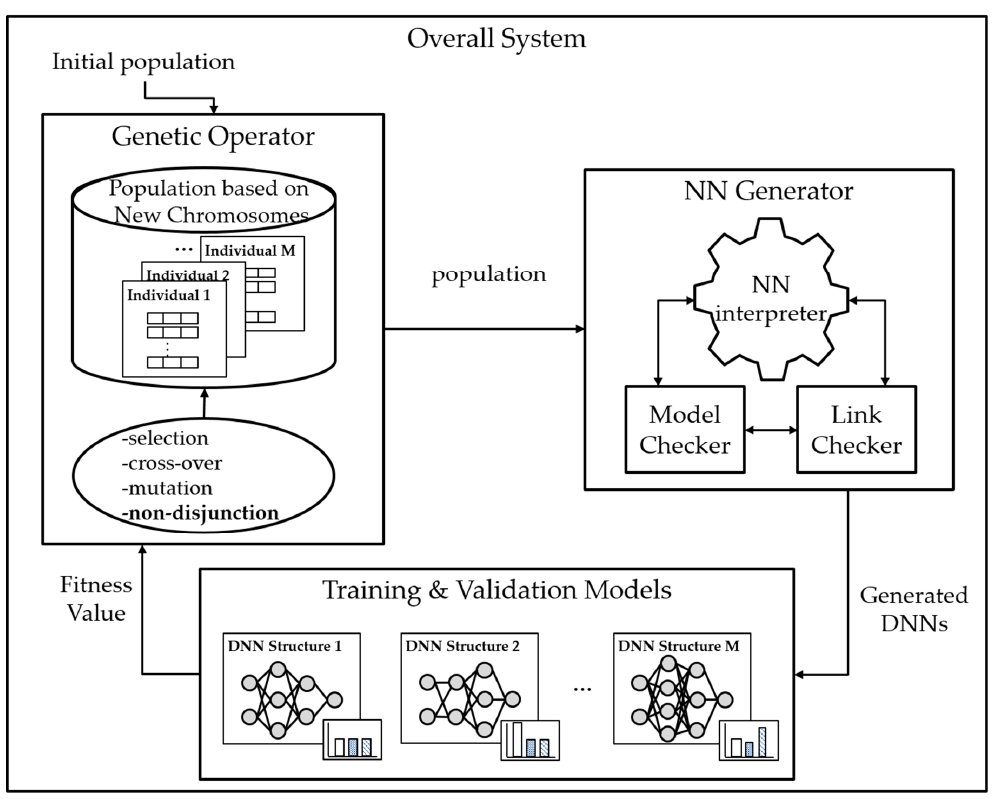
Figure 1. Overall methodology.